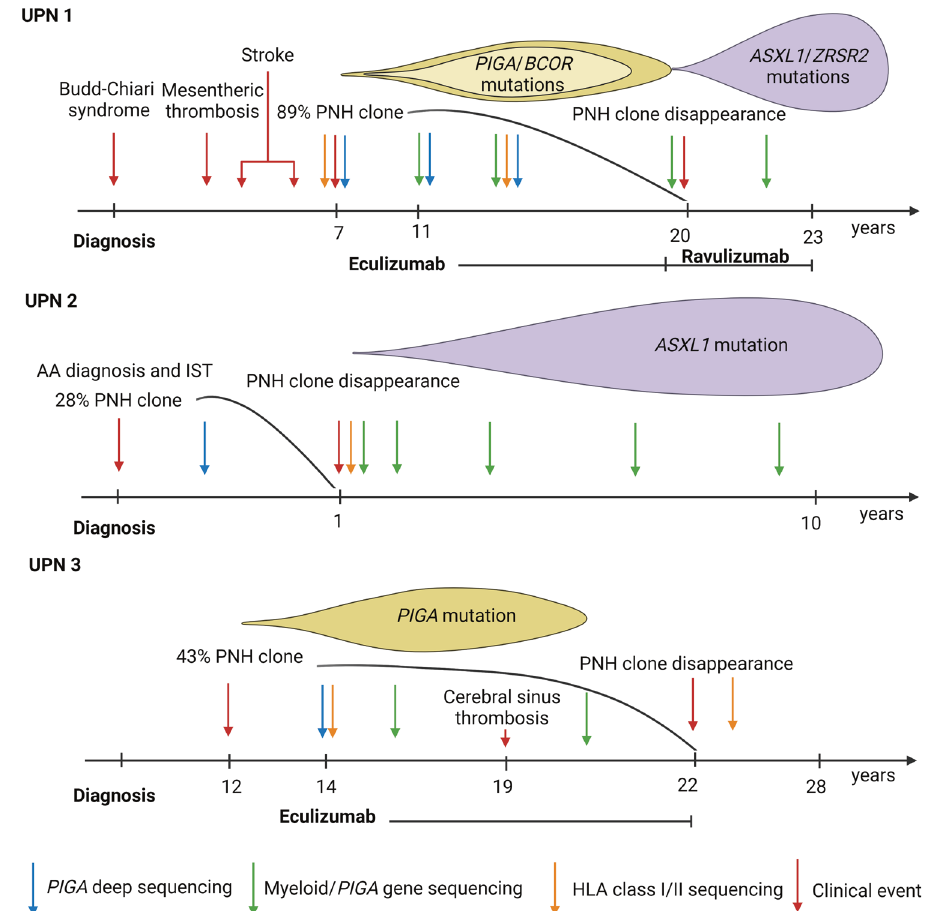
Fig. 1 Timeline of events for patients with PNH undergoing spontaneous remission. The fi gure showcases the disease course of the presented patients (UPN1-3) discussed in the main text as to clinical events (e.g., thrombotic complications, treatments), fl ow cytometric and molecular ( PIGA , myeloid, HLA panels)